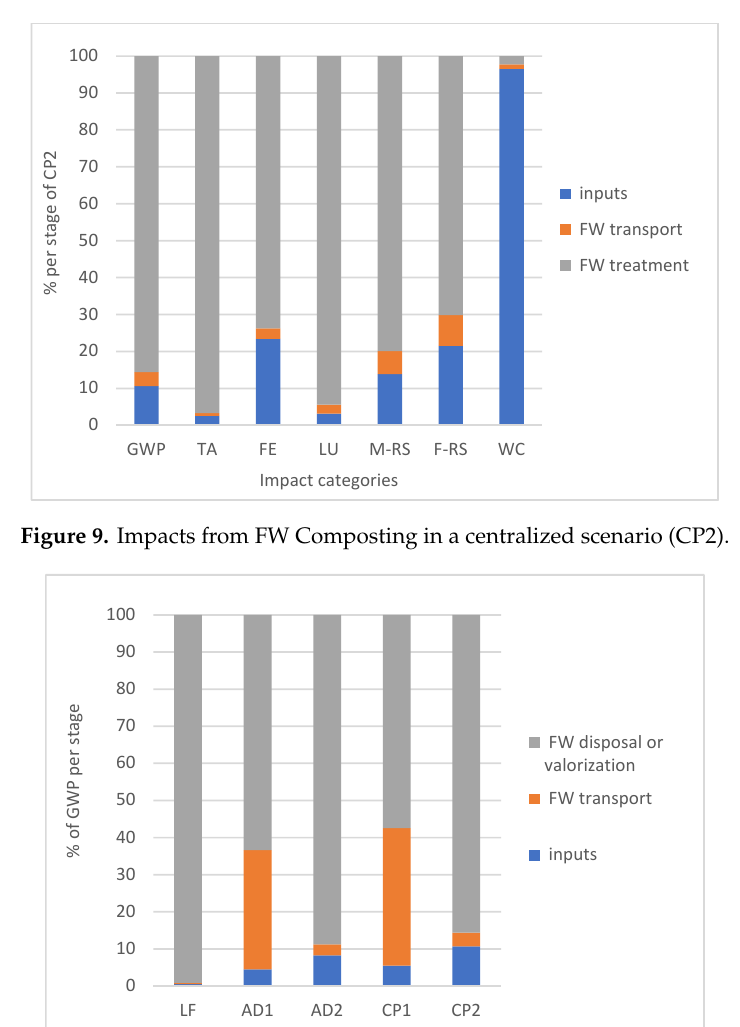
Figure 11. Contribution from each operation stage per FW treatment in the Land-Use impact category. While transport of the FW is almost imperceptible in the overall LF Global Warming Potential (it is assumed the FW would be transported from the generation sites to closer landfills), the centralized alternatives AD1 and CP1 show a considerable increase due to the transport of the FW in route 1, accountable for a distance of 126km. This impact is lowered in the semi-centralized scenarios AD2 and CP2, where the FW transport is responsible for less than 4% of that impact, consequent with the 33km in route 2. Besides the treatment or valorization process, transport operations remain as one of the main contributors in the centralized scenarios (AD1 and CP1) for the impact category concerning Land-Use as well. Regarding costs, the E-LCC showed that all valorization alternatives, except AD1, would result in higher yearly costs than LF (Table 5), and the contribution of the different elements of the cost will vary depending on each scenario (Figure 12). Table 5. Cost of the business as usual and alternative FW treatment scenarios, expressed in USD. Cost Category